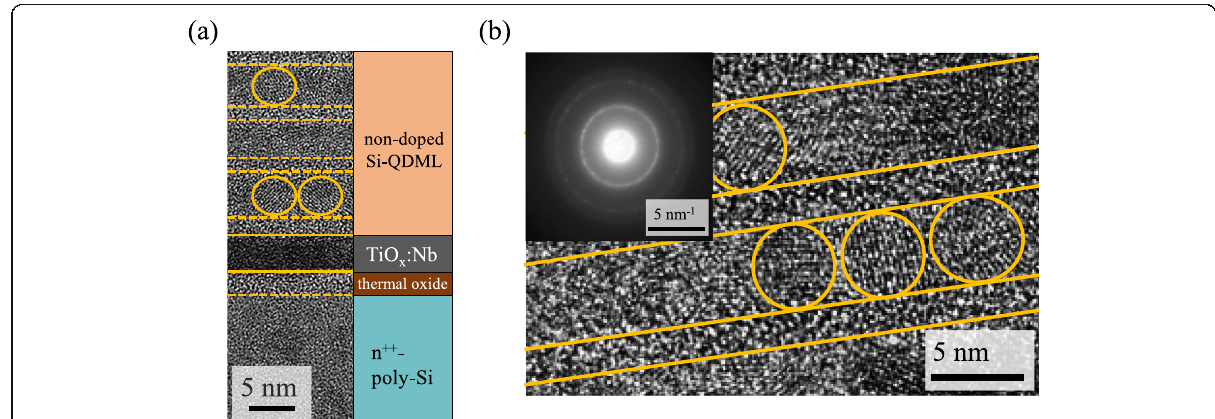
Fig. 2 Cross-sectional HRTEM images of a Si-QDML/TiO x :Nb/thermal oxide/n ++ -poly-Si structure and b Si-QDML. The inset in (b) is the electron diffraction